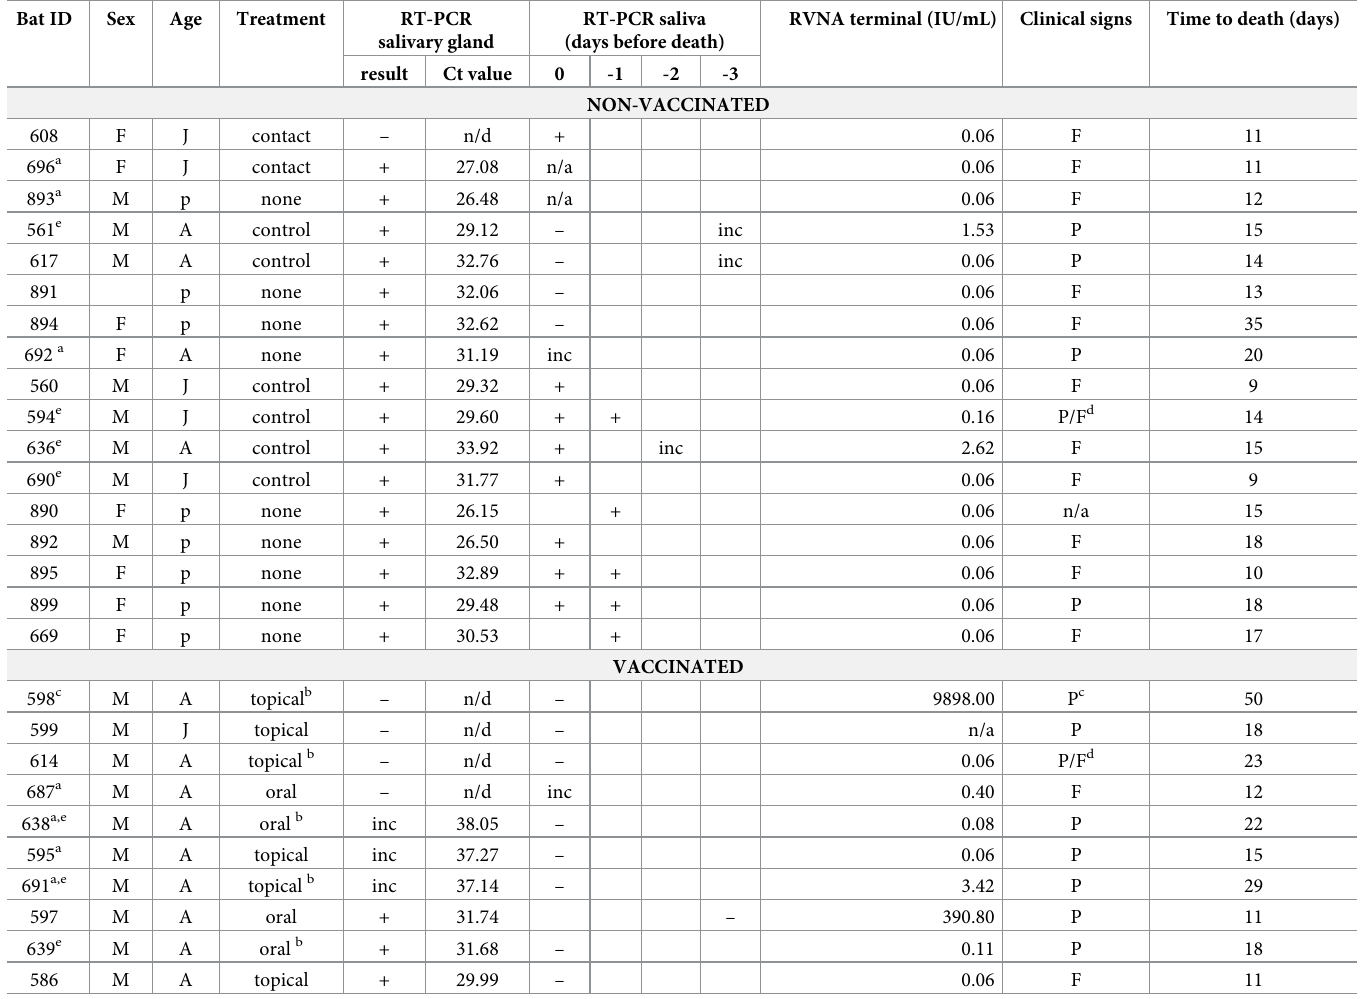
Table 3. Detection of RABV in salivary gland and RABV shedding in saliva by LN34 RT-PCR in bats confirmed positive for rabies in brain tissue by the direct fluo- rescent antibody test. According to a rotating group schedule, saliva samples were obtained on day of death (0) if possible, daily if clinical signs were observed, or 1–3 days before death. Symbols are: + “positive”,–“negative”, and “inc” inconclusive. Inconclusive results are those with a Ct value from 35–40 and could indicate low virus load, insufficient sample, or possible cross-contamination. A Ct value with n/d is “not detected”, n/a means sample was not available. Age groups are J = juvenile, A = adult, and p = pup. Clinical signs are categorized as furious (F) or paralytic (P), and time to death is the number of days from RABV challenge until the bat died or was